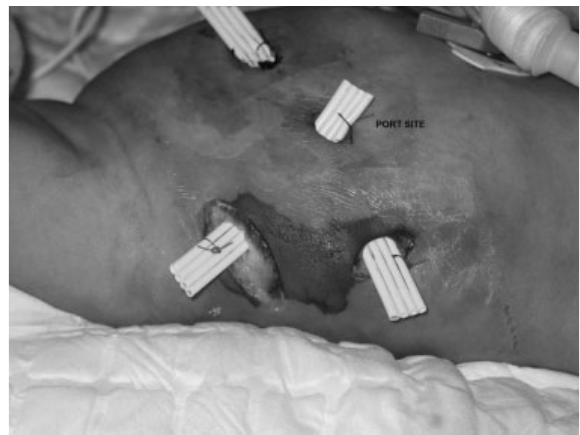
Fig. 1 Abdominal necrotizing cellulitis at day postoperative 6 after drainage and surgical incision.